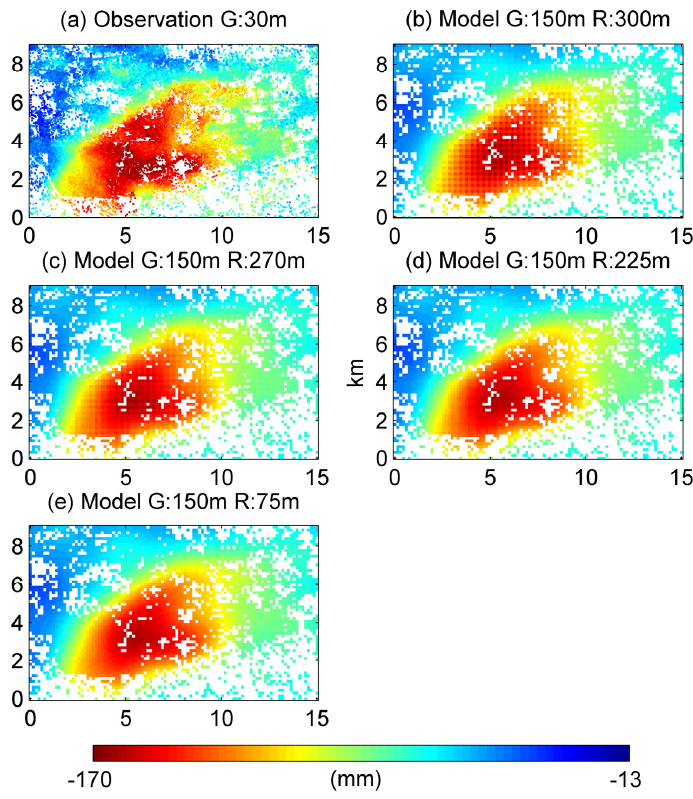
Figure 9. Observed LOS surface displacement ( a ) and Modeled LOS displacements with reservoir grid size of: ( b ) 300 m; ( c ) 270 m; ( d ) 225 m; and ( e ) 75 m.